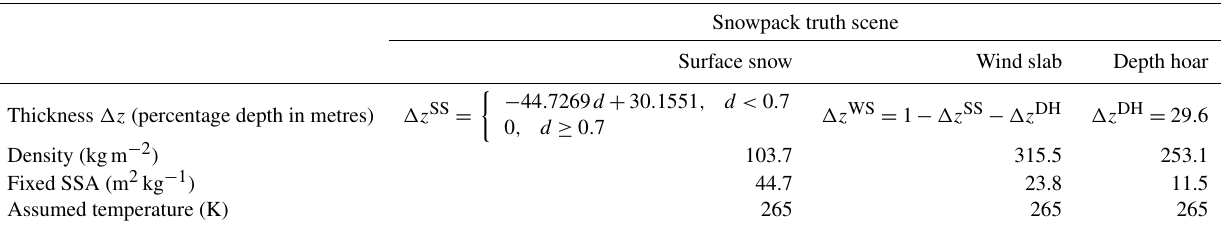
Figure 9. Change in snow layer (a) density and (c) SSA with relative thickness of snowpack layers: surface snow (red circle), wind slab (blue cross), and depth hoar (black star). Distributions of snow layer (b) density and (d) SSA: blue box (interquartile range), red line (median), and whiskers (dashed lines) extend from the end of each box to 1.5 times the interquartile range; outliers beyond this range are omitted. Table 3. SMRT parameters derived from TVC data. Thickness relationship derived from NIR-derived stratigraphy observed in 2013. Density and fixed SSA taken from median of all observations for that layer type in 2013 and 2018. Fixed SSA values were used in place of the SSA distribution when assessing the impact of spatial variability in other